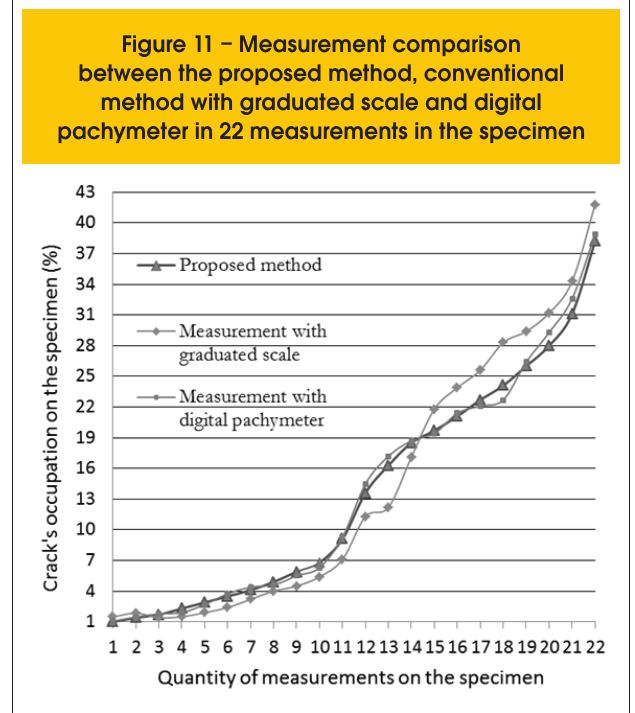
Figure 11 – Measurement comparison between the proposed method, conventional method with graduated scale and digital